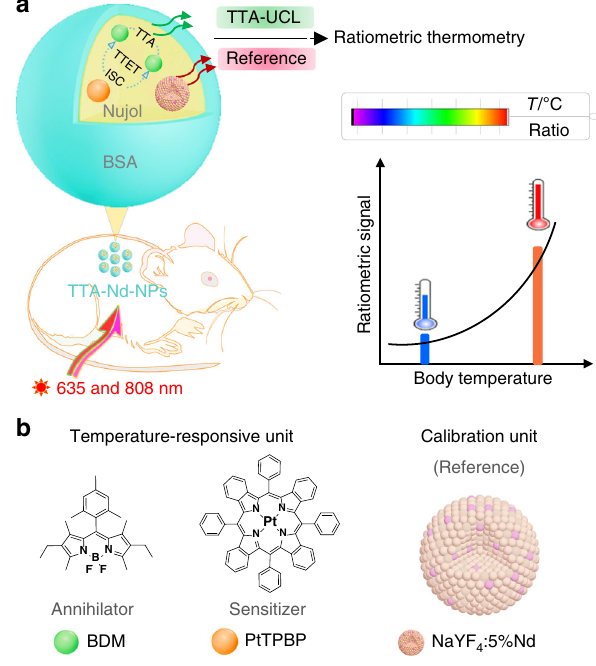
Fig. 1 Schematic illustration of the TTA-Nd-NPs based ratiometric thermometry in vivo. a TTA-upconversion is sensitively responsive to temperature changes. With the assistance of an internal reference, the calibrated TTA-UCL signals become capable for accurate temperature monitoring in a small animal. b Chemical structures of the TTA chromophores containing BDM (TTA annihilator) and PtTPBP (TTA sensitizer), and schematic structure of the Nd 3 + nanophosphor